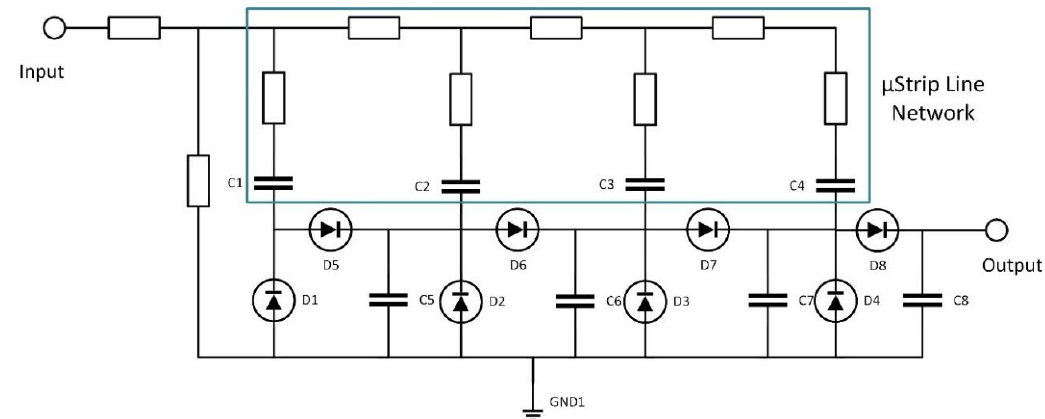
Figure 6. L-network in combination with the microstrip line network is equivalent to the T- Impedance Matching Network (IMN).